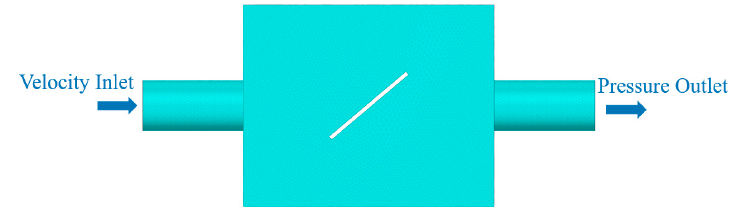
Figure 11. CFD model of the REC with one baffle.